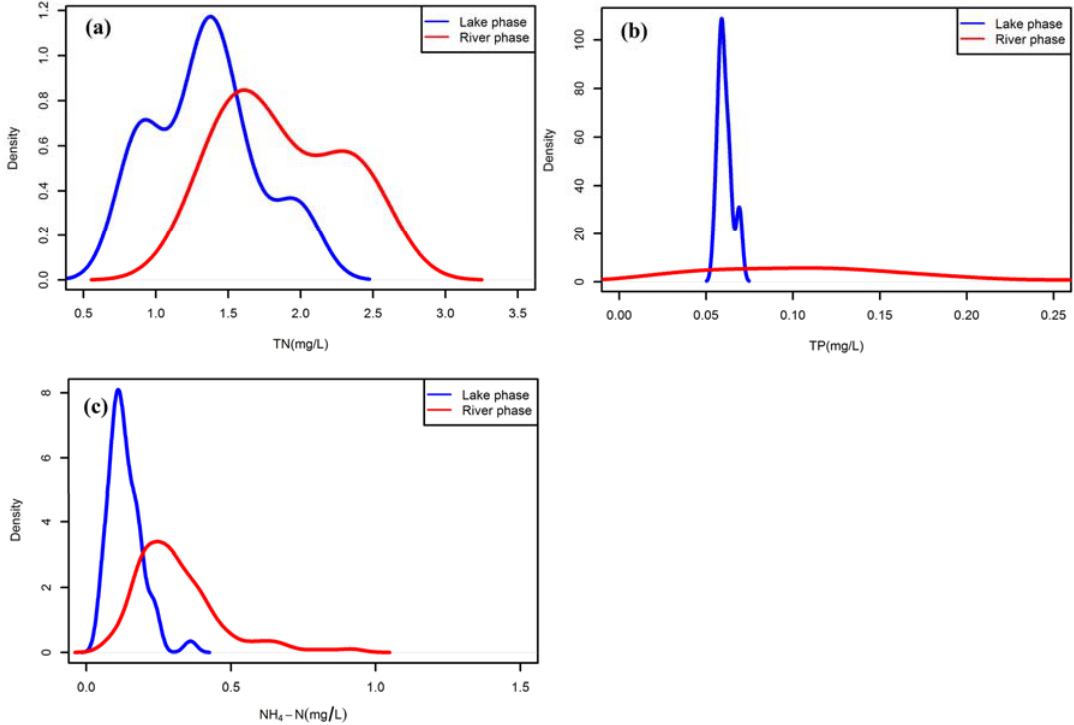
Figure 8. Probability density lines of nutrient indicators for lake phase (water level >14 m) and river phase (water level <14 m). ( a ) TN; ( b ) TP; ( c ) NH 4 –N.